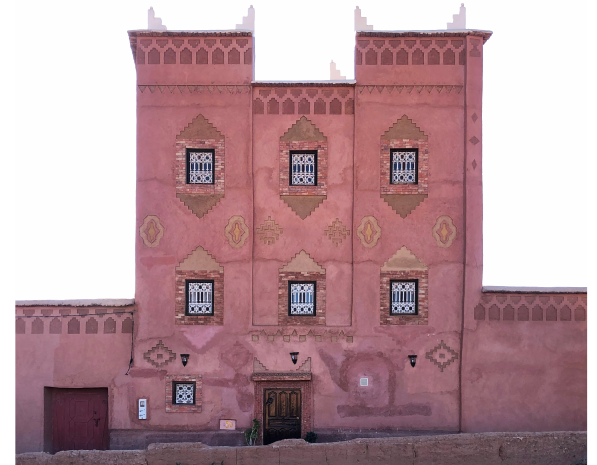
Figure 17. “Gîte Assafar”, Ait Khyar.